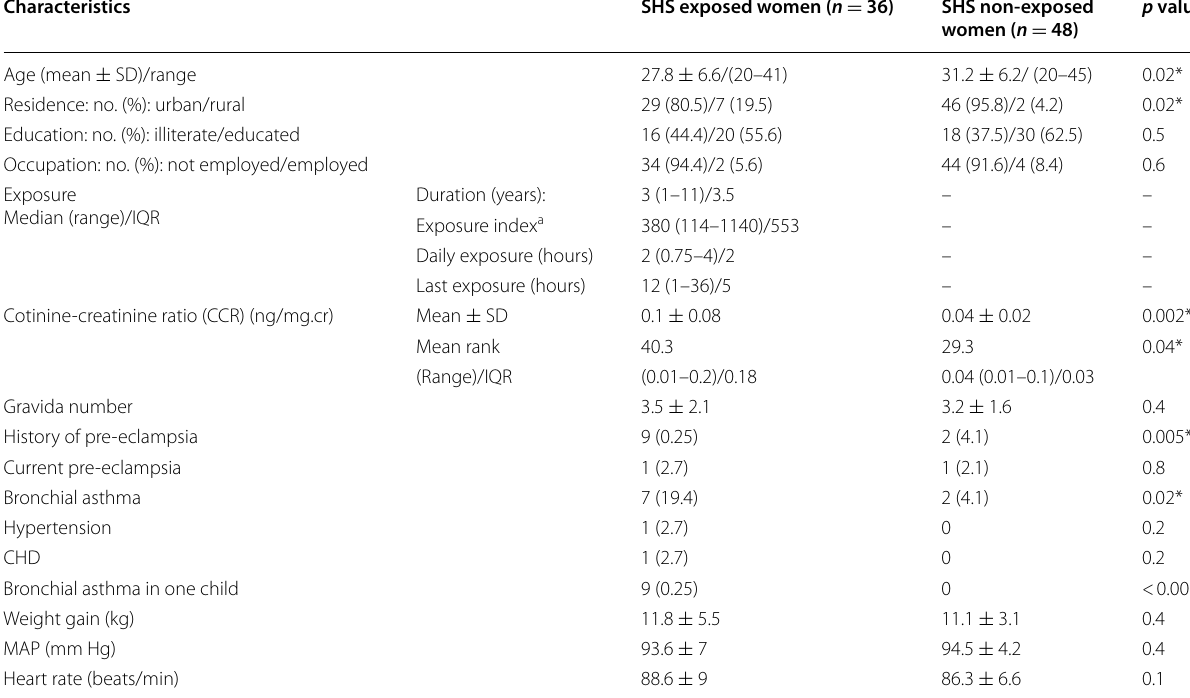
a The exposure index is the product of no. of smokers in the house, average no. of cig/day in the presence of the pregnant women, the period of gestation in weeks